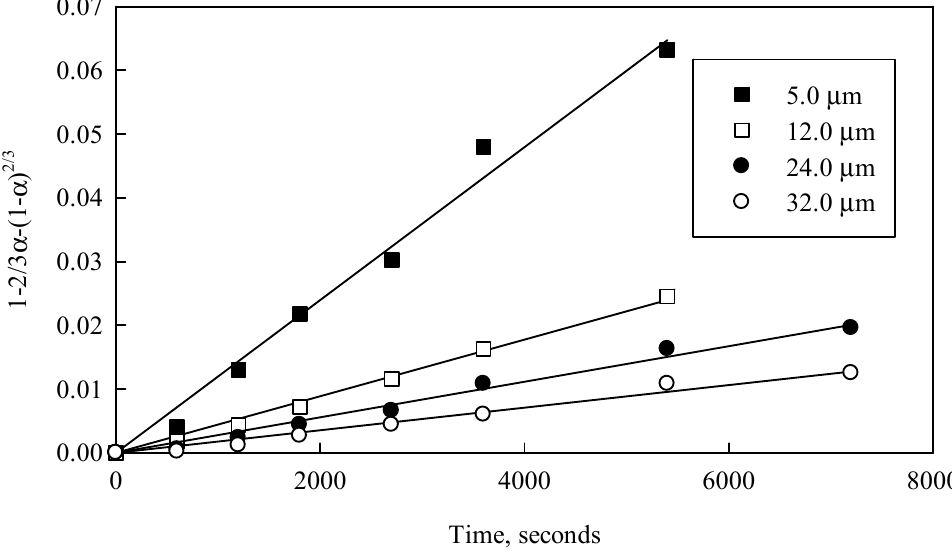
Figure 15. Malachite leaching kinetics for di ff erent average particle sizes. Working conditions are the same as those in Figure 7.